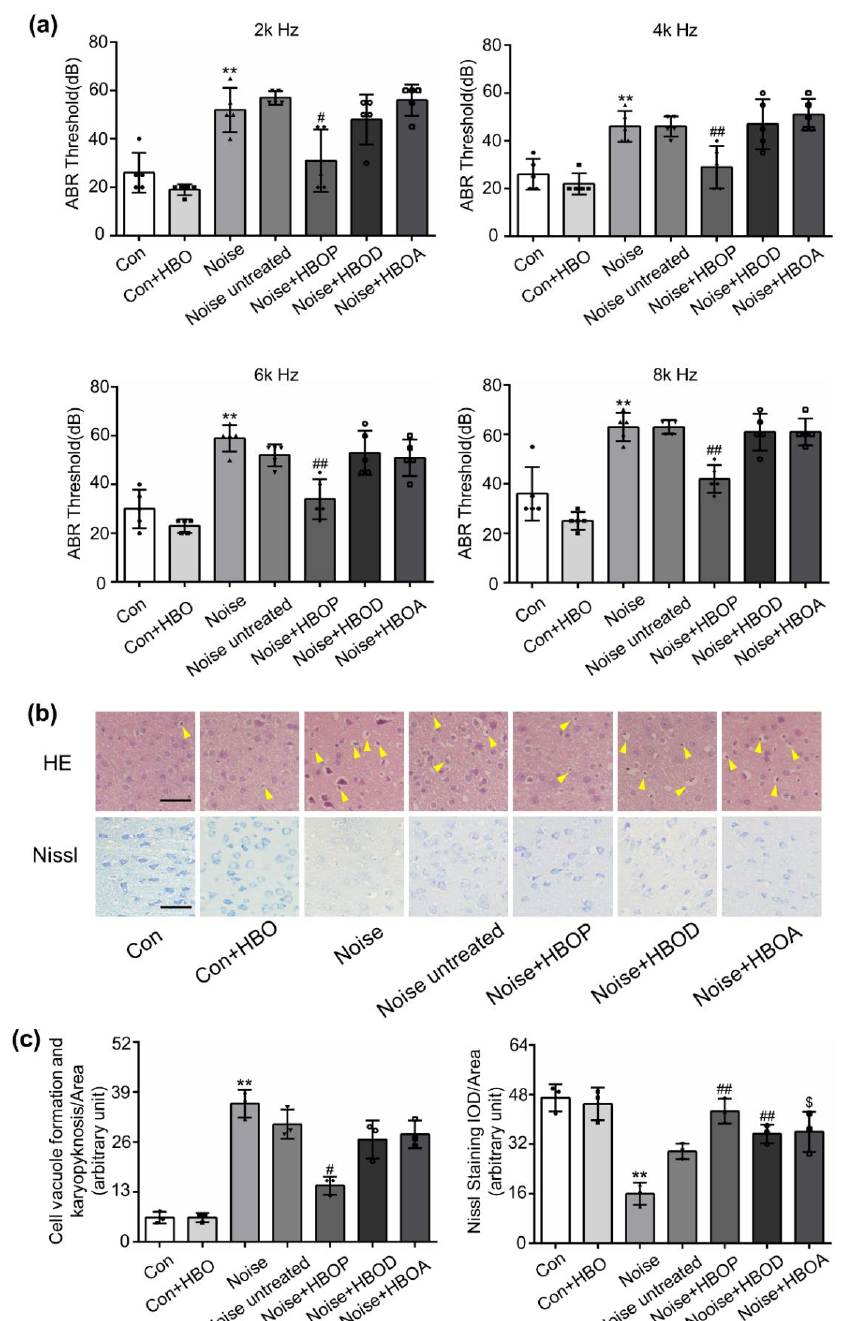
Figure 1. Auditory brainstem response (ABR) threshold to sound with frequency of 2k, 4k, 6k, or 8k Hz ( a ), original images ( b ) and summarized data ( c ) of hematoxylin and eosin (HE) or Nissl staining in auditory cortex (AC) of mice in Con, Con + HBO, Noise, Noise untreated, HBOP, HBOD, and HBOA. The arrows indicate the vacuole formation and karyopyknosis in the neuron, magnification × 400, scale bar = 50 µ m. Data is shown as means ± SD, n = 5 in ABR, n = 3 in HE or Nissl staining, ** P < 0.01, * P < 0.05 vs. Con, ## P < 0.01, # P < 0.05 vs. Noise, $ P < 0.05 vs. Noise untreated. All individual data points were shown in the figure using di ff erent shapes, • for Con group, (cid:4) for Con + HBO group, (cid:78) for Noise group, (cid:72) for Noise untreated group, (cid:95) for Noise + HBOP group, for Noise + HBOD group, (cid:3) for (cid:35) Noise + HBOA